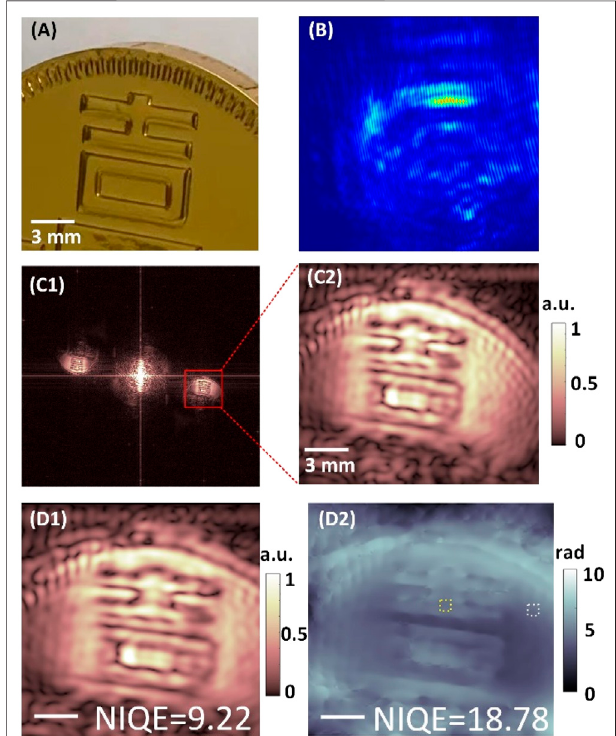
FIGURE 4 | Reconstruction results of the gold-coated tinfoil sample. (A) Picture of the illuminated area of the object; (B) and (C1) are the digital hologram and reconstructed amplitude image; (C2) is the zoomed area of the +1 order in (C1) ; (D1) is the reconstructed amplitude map after tilted plane correction; (D2) is the reconstructed unwrapped, aberration-free and corrected phase